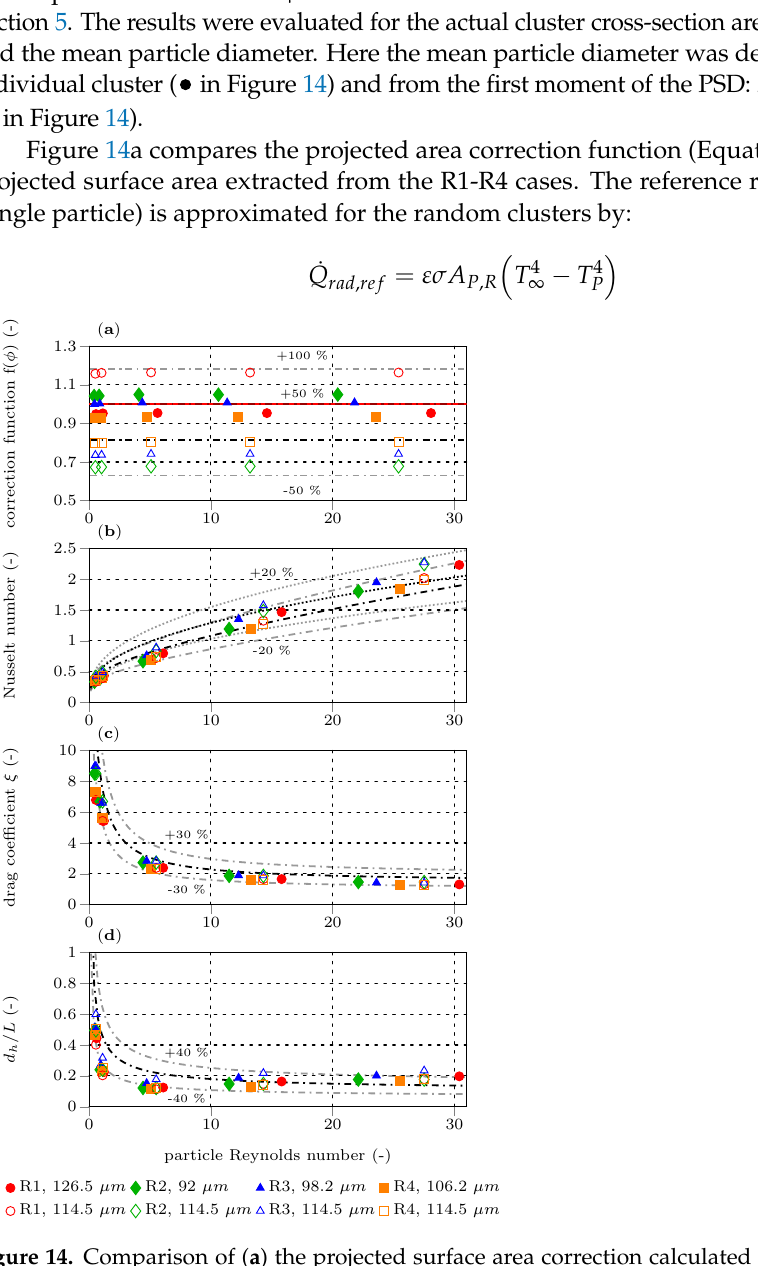
Figure 14. Comparison of ( a ) the projected surface area correction calculated using Equation (13) ( ) ( b ) the Nusselt number calculated using Equation (16) ( ) and Equation (17) ( ), ( c ) the drag coefficient according to Equation (20) ( ), and ( d ) d h / L calculated using Equation (19) ( ) with values determined from simulations ( ) versus the cluster particle Reynolds number. The simulations deviate from the correlation by up to 50% for the cluster mean ± particle diameter, while the statistical mean diameter deviate up to 100%. The statistical ± mean diameter falsifies the comparison because of a wrong reference heat flux. The higher values of the mean diameter cases clearly indicate a bias of the regular synthetic cluster arrangement, which maximizes the shading effects. Furthermore, the correction values reveal an additional dependence on the particle size, which was disregarded in this